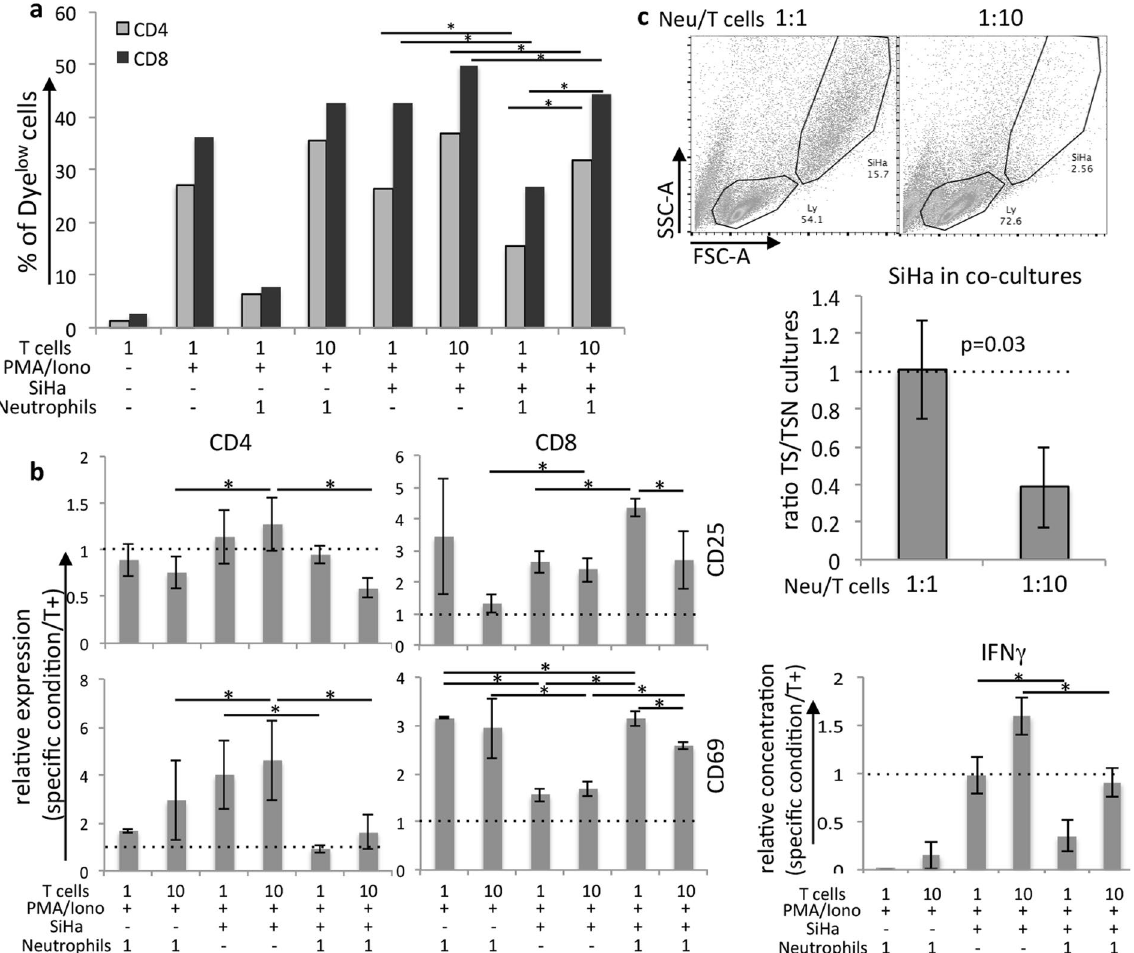
Figure 6. Effects of neutrophils over T cell activity in a tumor-like environment. Cell proliferation dye labeled T cells were stimulated with 100 ng/ml TPA and 1 μ g/ml ionomycin (TPA/Iono) for 5 hours, before they were washed and added to neutrophils cultures (in 1 T cell: 1 neutrophil or 10 T cells: 1 neutrophil ratios), or 4 days SiHa spheroid cultures (SiHa) or neutrophils previously incubated for 5 hours with 4 days SiHa spheroid cultures. After 5 days incubation, cells were harvested and labeled with anti-CD45, CD4, CD8, CD25, CD69, fixed, and labeled with 10 μ g/ml DAPI and then analyzed by flow cytometry. ( a ) For proliferation analysis, we gated out debris and doublets, than gated on CD45 + cells and then CD4 + or CD8 + cells, where we evaluated the percentage of cells that had low Cell Proliferation dye fluorescence, compared to a non-stimulated T cell control. Experiment representative of 4 independent ones (there was variation among cells from different donors). Numbers indicated in the graph, show the average of the proliferation ratios between T cells in 1:1 and 1:10 cultures with neutrophils incubated with SiHa spheroids in 4 independent experiments. ( b ) Relative CD25 and CD69 expression in the same cultures described in ( a ), as well as concentration of IFN γ in the cultures supernatant measured with the CBA kit (BD Biosciences). Results are the average of 4 independent experiments, and were tested by one-way ANOVA, either comparing 1:1 culture conditions and 1:10 culture conditions; * indicates significant differences between experimental groups, dotted lines indicate ratio 1. ( c ) Depletion of SiHa cells from cultures with 10:1 T cells/neutrophils. Dot-plots on top represent the SiHa cells gate obtained after cells harvesting and flow cytometry analyzes. Total absolute cell numbers were determined by counting cells suspensions using a hemocytometer. These numbers were multiplied by the frequency of SiHa cells to obtain the absolute SiHa numbers per experimental condition. The graph bellow shows the ratio of SiHa cell numbers in SiHa/T cells cultures (TS) divided by the SiHa cell numbers in SiHa/neutrophils/ T cells cultures (TSN) in the different T cell/neutrophil experimental ratios. Results are the average of 3 independent experiments, tested by t-test, p value indicated in the graph, dotted lines indicate ratio